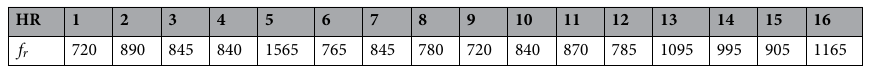
Table 3. Resonance frequency in Hz of the HRs composing the optimized FMAA.